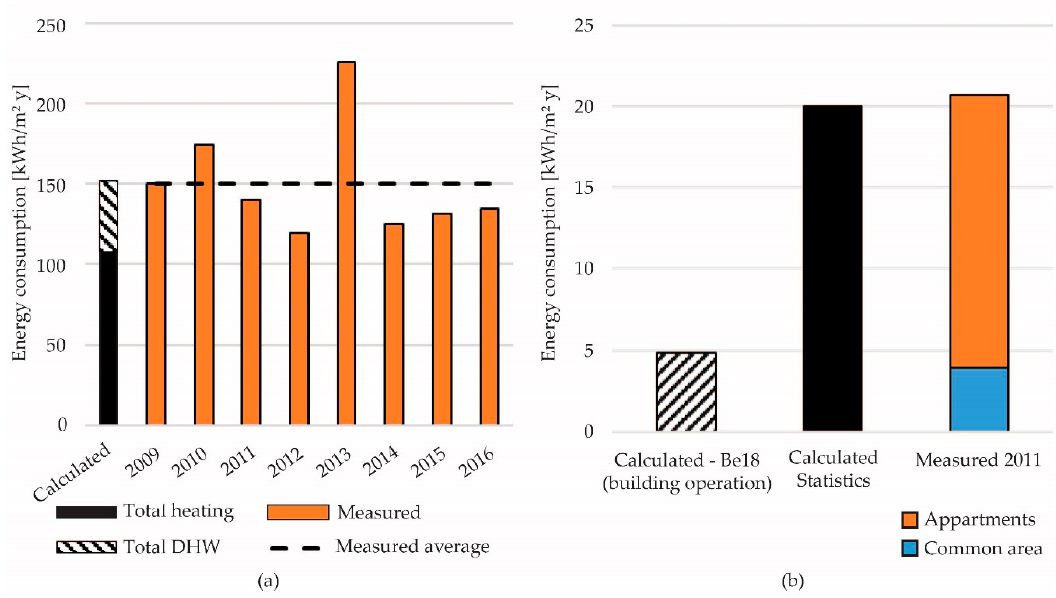
Figure 3. Energy demand of the Danish case study. Comparison of total calculated and measured: heating ( a ); and electricity ( b ).